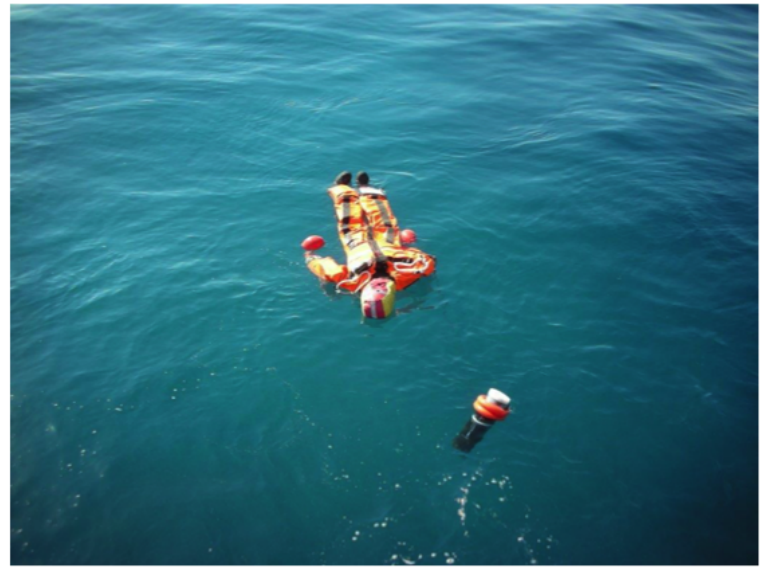
Figure 3. Image of 2 June 2015 showing the dummy with the GPS transmitter (black and orange cylinder) attached to its neck used in the Valencia experiment. Copyright SASEMAR with